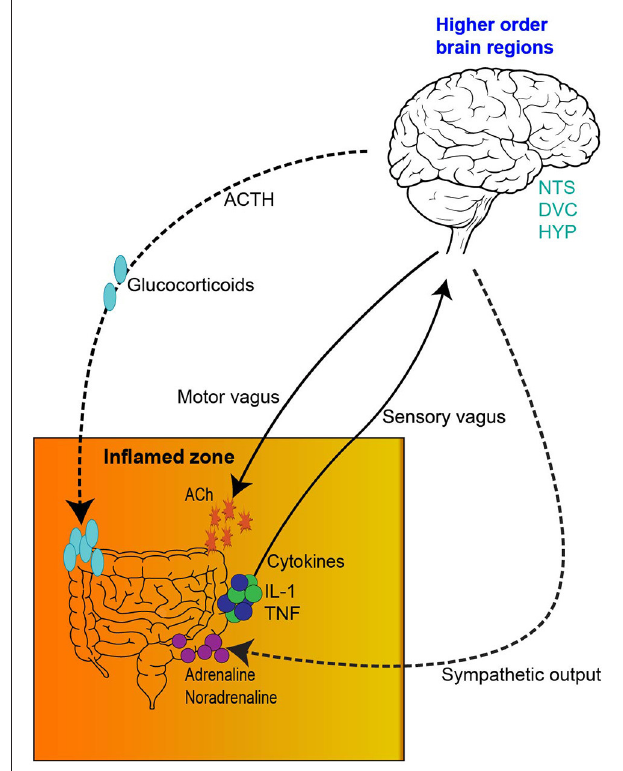
FIGURE 1 | The inflammatory reflex. (1) The inflamed zone represents tissue damage, infection and ischemia. (2) Increased expression of inflammatory mediators and cytokines, such as Il-1 β and TNF- α are released by cells in the inflamed zone. (3) Cytokines activate primary afferent neurons within the vagal sensory ganglia. (4) Afferent visceral signals are relayed to nuclei in the dorsal vagal complex (DVC), such as the nucleus tractus solitarius. (5) Visceral information is further relayed from the DVC to higher order brain regions, such as the hypothalamus, hippocampus and forebrain. (6) Activation of efferent vagal motor activity inhibits cytokine synthesis. (7) Hypothalamus activation stimulates the release of adrenocorticotrophic hormone from the pituitary gland, initiating a humoral anti-inflammatory pathway. (8) Sympathetic outflow can increase localized adrenaline and noradrenaline expression further suppressing inflammation. IL-1 β , interleukin-1 beta; TNF- α , tumor necrosis factor—alpha; DVC, dorsal vagal complex; NTS, nucleus tractus solitarius; HYP, hypothalamus; HIP, hippocampus; FB, forebrain; ACTH, adrenocorticotrophic